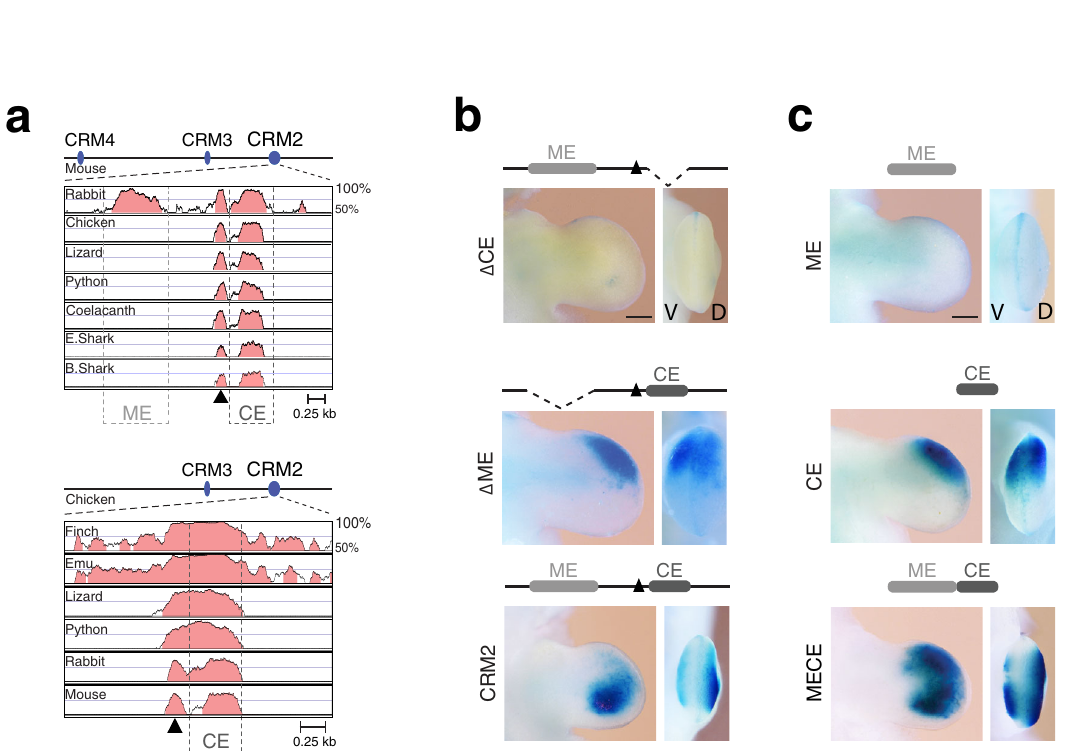
Fig. 5 The deeply conserved CE region is essential for CRM2 activity but posterior activity depends on interaction with the ME region. a Conservation plot analysis using the mouse (upper panel) and chicken (lower panel) CRM2 regions reveals the deep evolutionary conservation of CE region and Fmn1 exon 22 (black arrowhead). In contrast, the upstream ME region that is conserved among mammalian species, is not detected in Sauropsida and basal fi shes. Note the extensive conservation of the CRM2 region among different bird species. Regions with ≥ 70% conservation are shaded in light red. b Deletion analysis of the mouse CRM2 enhancer activity. Upper panel: deletion of the deeply conserved CE region ( Δ CE) abolishes LacZ reporter activity ( n = 6/7, proximal activity n = 1/7). Note that a few posterior cells with enhancer activity have been observed ( n = 2/7). Middle panel: deletion of the mammalian-speci fi c ME region ( Δ ME) restricts LacZ reporter activity to the anterior-distal limb bud mesenchyme ( n = 5/6) in comparison to the intact CRM2 enhancer (lower panel, n = 9/11). c On its own, the ME region has no activity (upper panel, n = 0/4), while the CE region is active in the anterior- distal mesenchyme (middle panel, n = 4/5, activity throughout the limb bud n = 1/5). A LacZ reporter construct encoding both the ME and CE regions restores posterior activity but also retains anterior expression (lower panel, n = 7/7). The dorso-ventral bias in CRM2 activity together with the restriction from the sub-ectodermal region as observed for Grem1 expression 22 is also partially restored ( n = 7/7). The transgenic founder embryos that express LacZ in forelimb buds are indicated as the fraction of all embryos with LacZ expression in limb and non-limb tissues. Scale bars: 250 μ